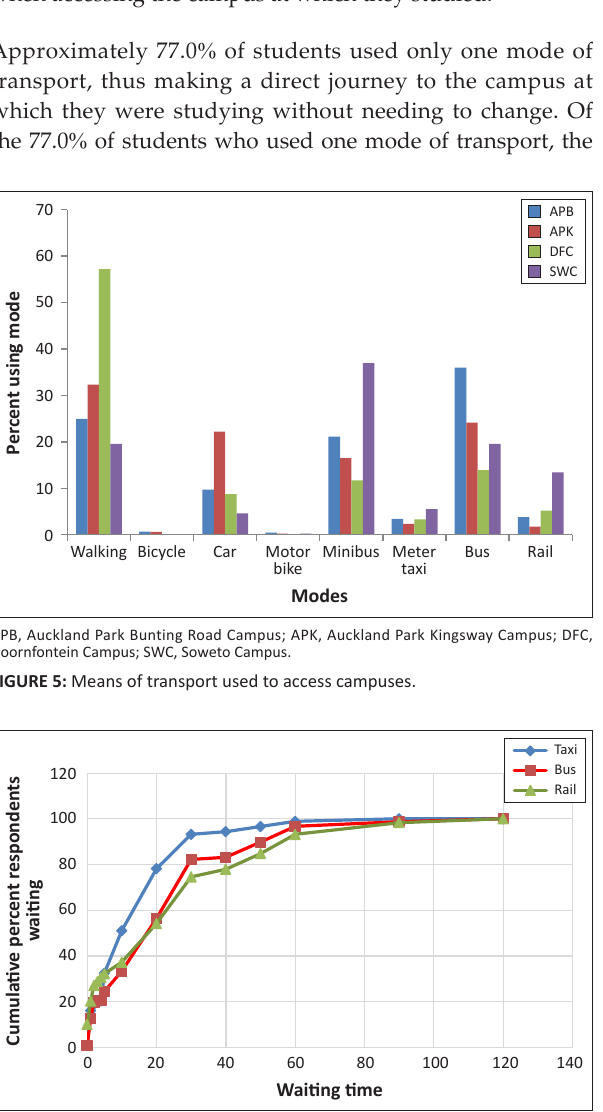
FIGURE 6: Cumulative waiting time by